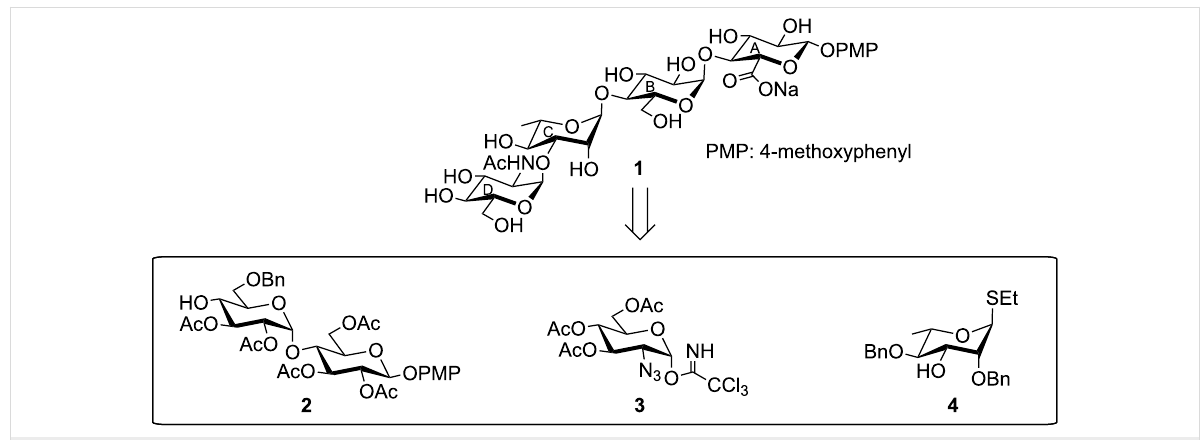
Figure 2: Structure of the synthesized tetrasaccharide and its